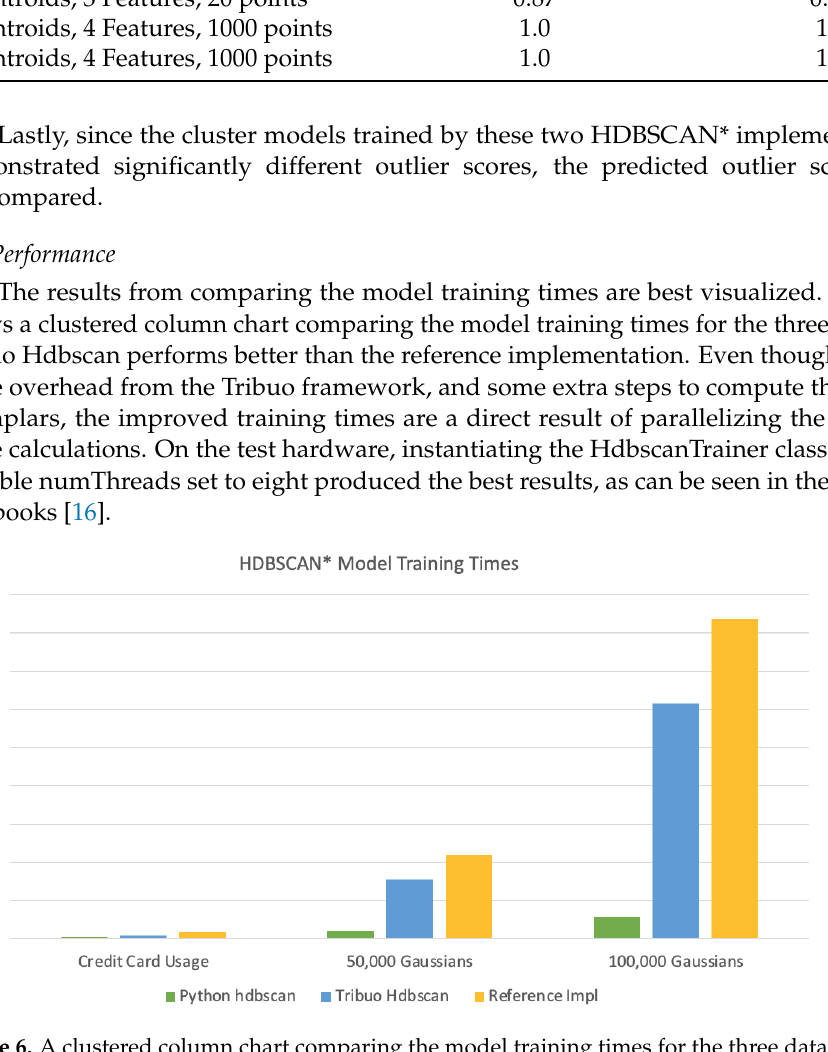
Figure 6. A clustered column chart comparing the model training times for the three